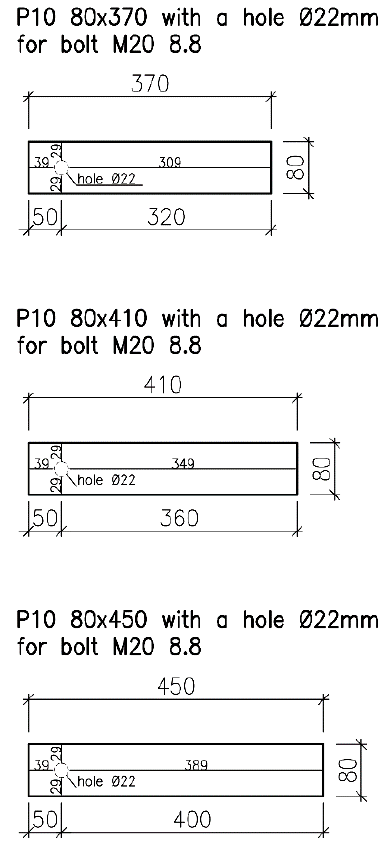
Figure 5. Dimensions of steel plates for tension tests parallel to the grain.